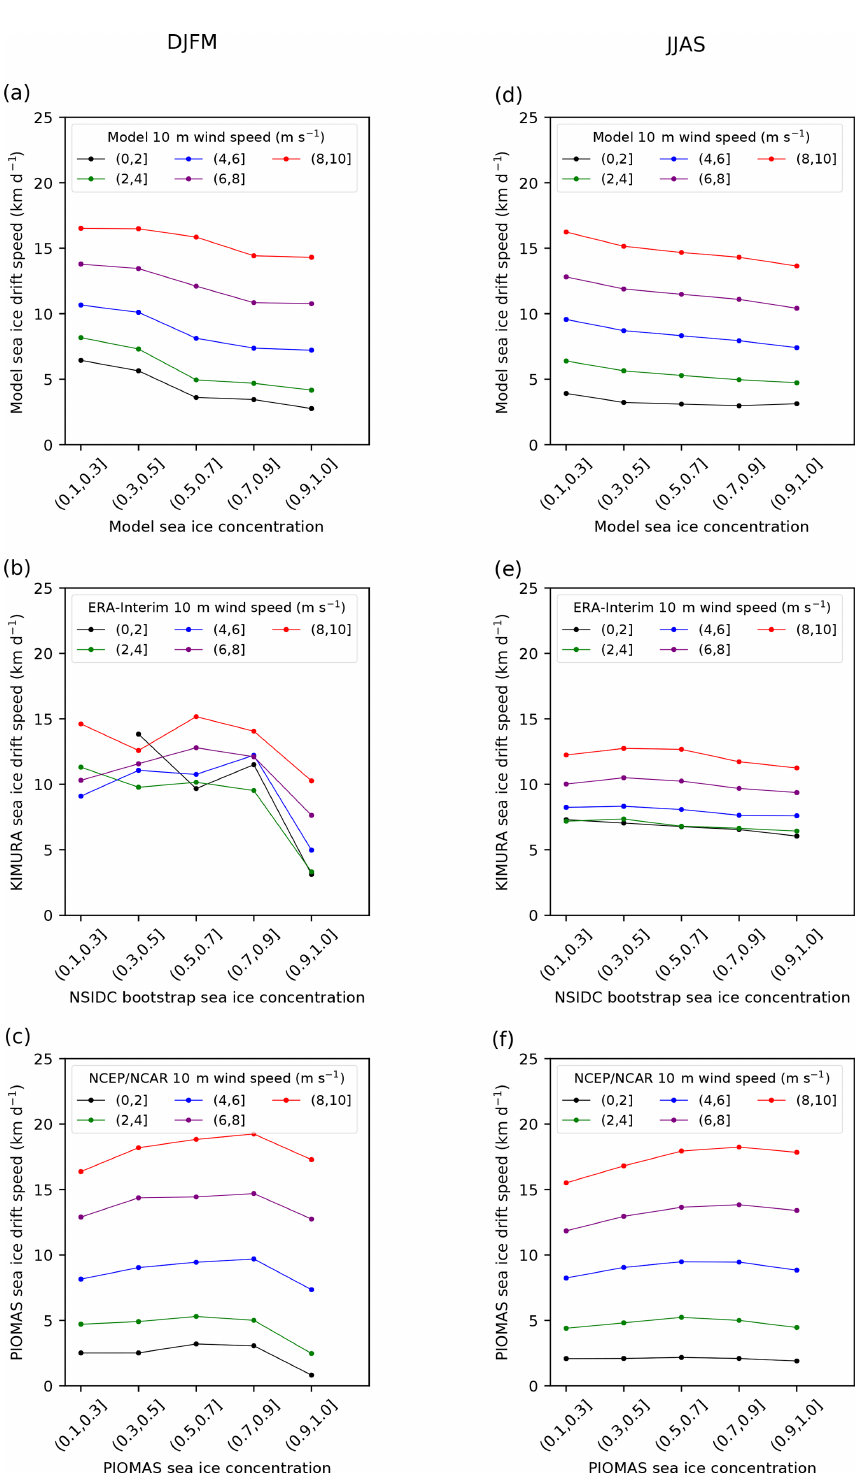
Figure 5. Relationship between sea ice drift speed and sea ice concentration for different near-surface wind speed classes (different colors) for the 2003–2014 (a) winter (DJFM) and (d) summer (JJAS) in the model (HIRHAM–NAOSIM 2.0). Panels (b) and (e) are the same as (a) and (d) , respectively, but based on the observation/reanalysis data. Panels (c) and (f) are the same as (a) and (d) , respectively, but based on PIOMAS data. The points in the plot are the median value of all the daily data and on all grid points for a certain wind speed and sea ice concentration, within the study domain indicated in Fig. 1. In the labels of different sea ice concentration and 10m wind speed classes, “(” means exclusive and “]” means